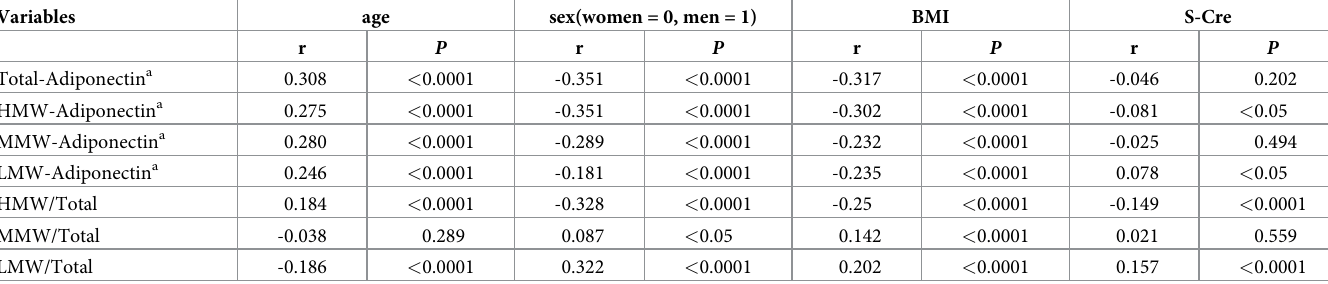
Table 3. Correlations between various adiponectin-related parameters and clinical parameters in the 1 st group. Variables